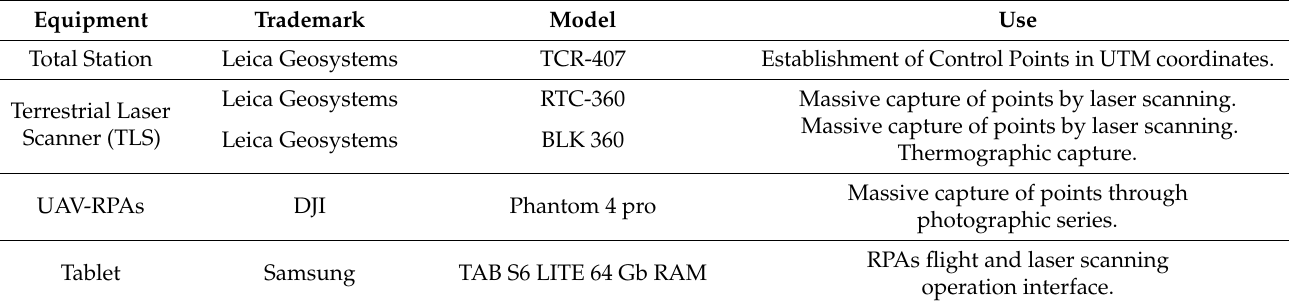
Table 3. Material resources used in the massive point capture.